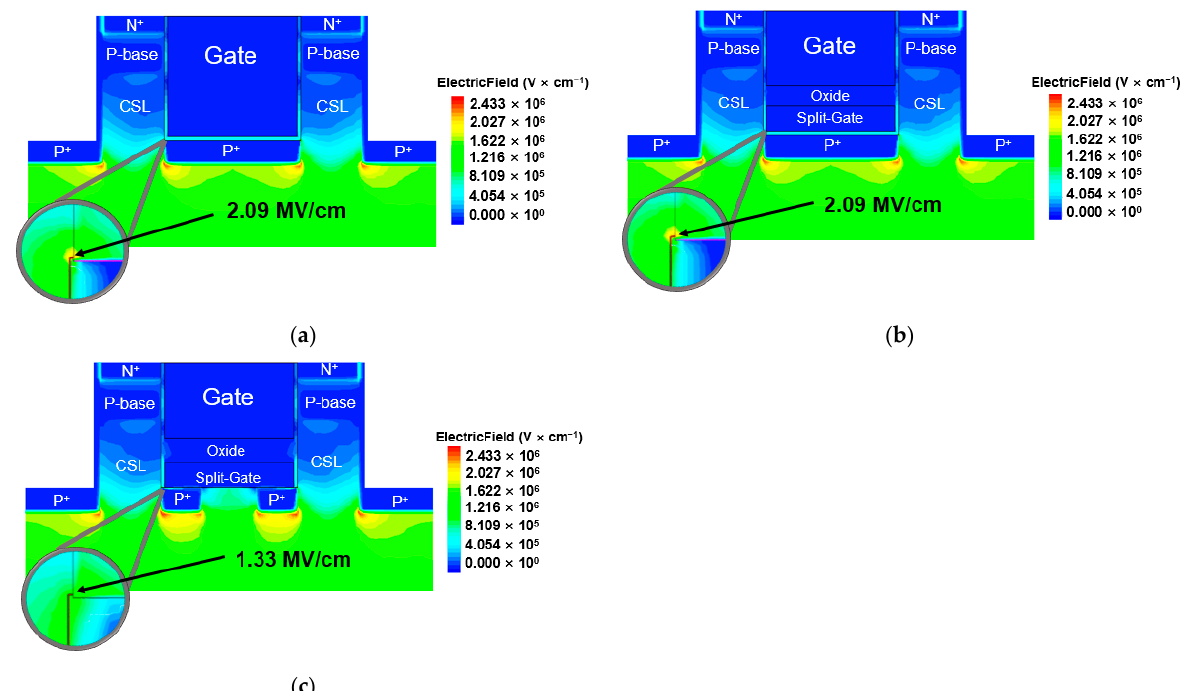
Figure 3. Schematic cross-sectional view of electric field distribution at V DS = 1200 V ( a ) Con-DTMOS, ( b ) SG-DTMOS, and ( c ) SHG-DTMOS.